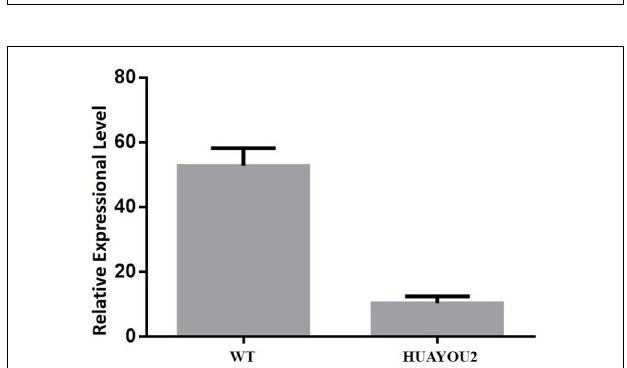
FIGURE 2 | Genetic map (left, units: cM) of BoWax1 on chromsome C01 (A) . The corresponding physical map positions (right, units: Mb) are also shown (B) .